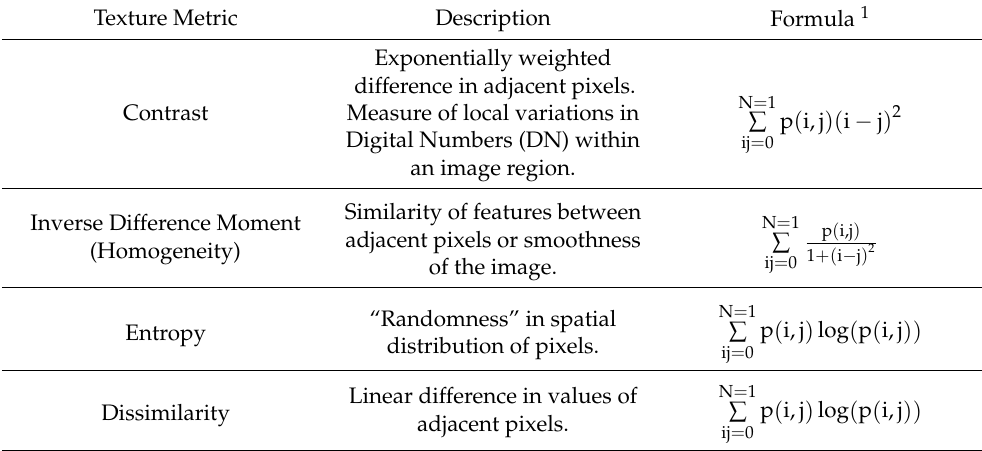
Table 3. Overview, description, and formula of applied textural metrics based on [29,41].